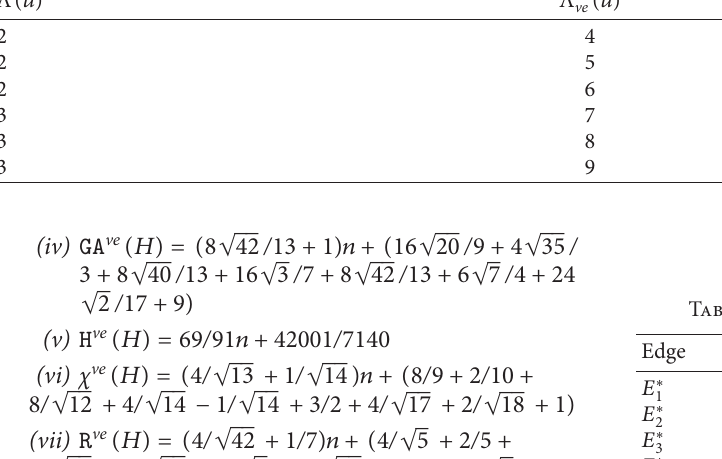
Table 5: The vertices’ ve-degrees of H